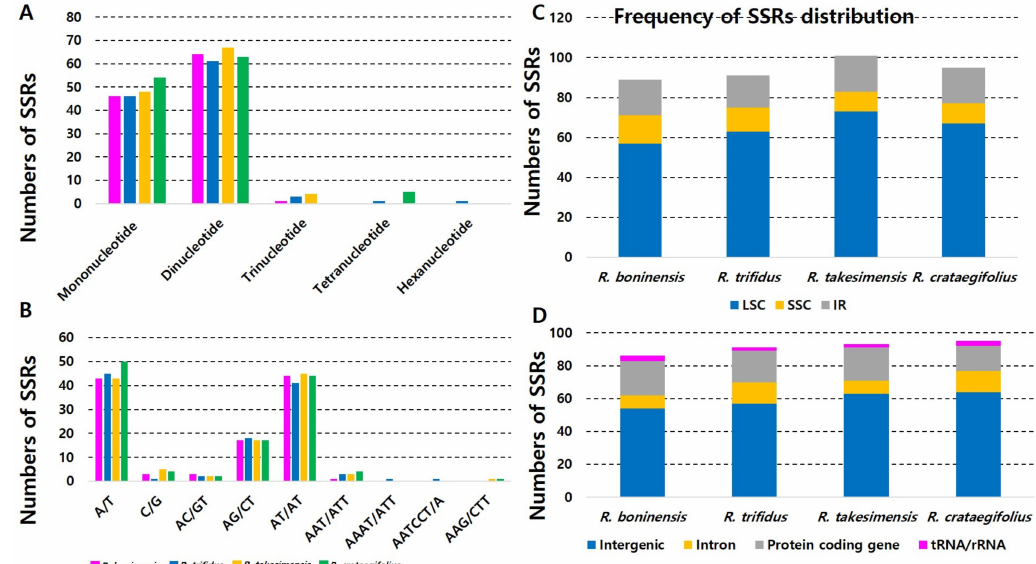
Figure 2. Analyses of repeated sequences in four Rubus plastome sequences. ( A ) Numbers of three repeat types; ( B ) numbers of identified SSRs motifs in di ff erent repeat class types; ( C ) frequency of repeat types in LSC, SSC, and IR regions; ( D ) frequency of repeat types in intergenic, intron, protein coding region, and tRNA /